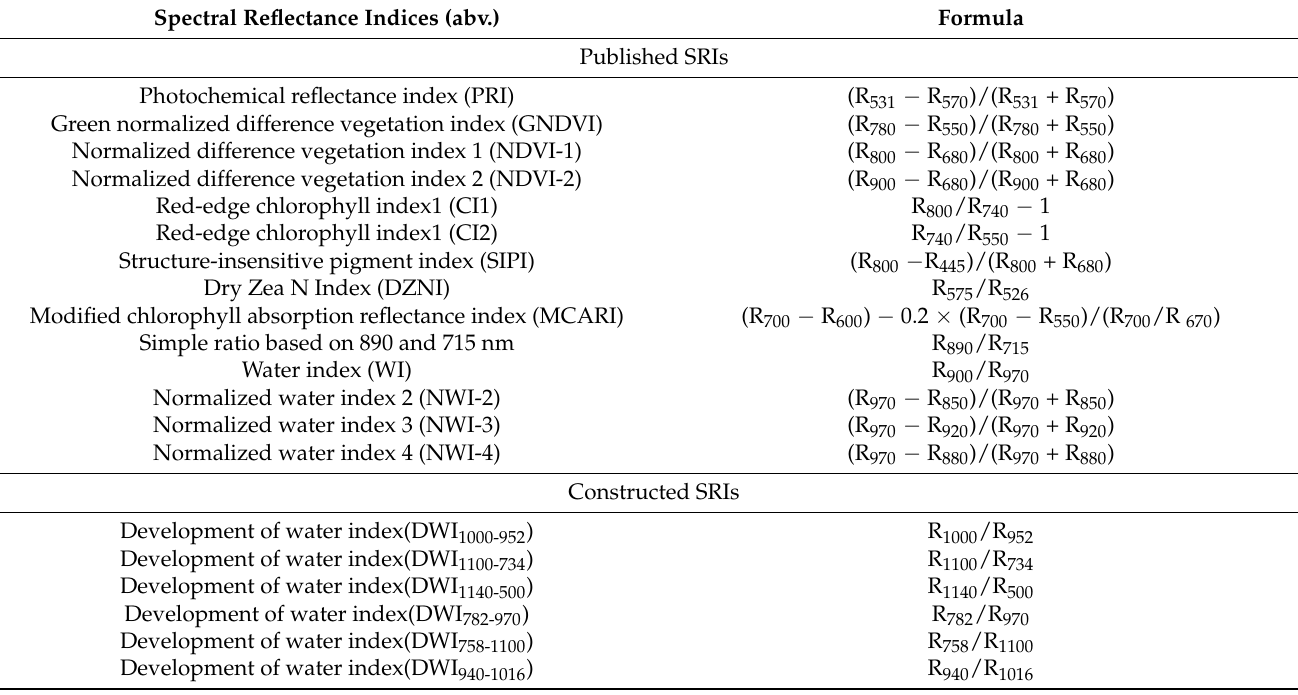
Table 2. Full name, abbreviation (abv.), and formula of the different published and constructed spectral reflectance indices (SRI) tested in this